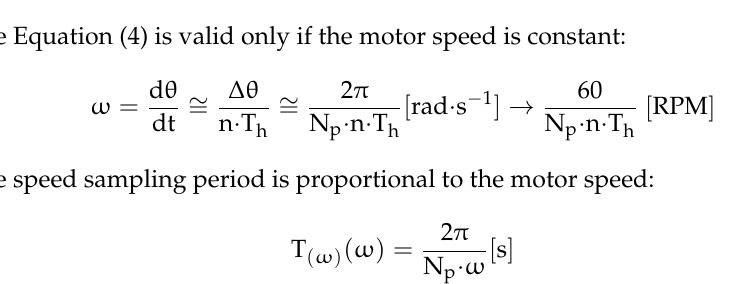
Figure 1. Incremental encoder. The period measurement by a high-frequency